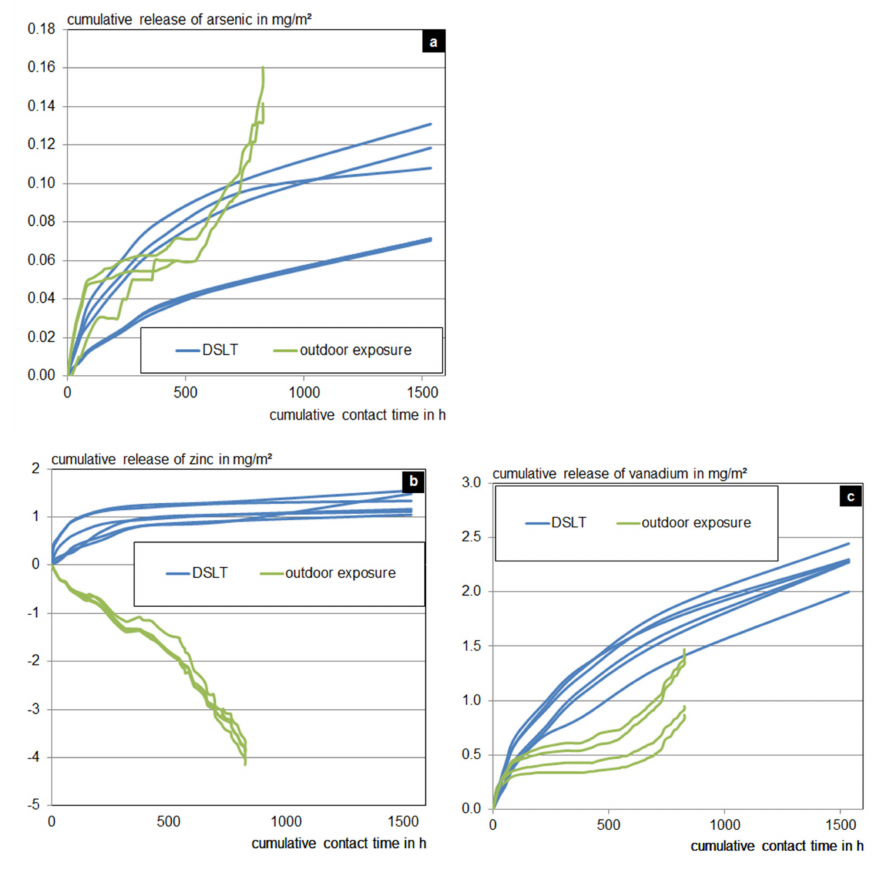
Figure 3. Cumulated emissions of ( a ) arsenic, ( b ) zinc and ( c ) vanadium in the dynamic surface leaching test and under outdoor exposure conditions (data of